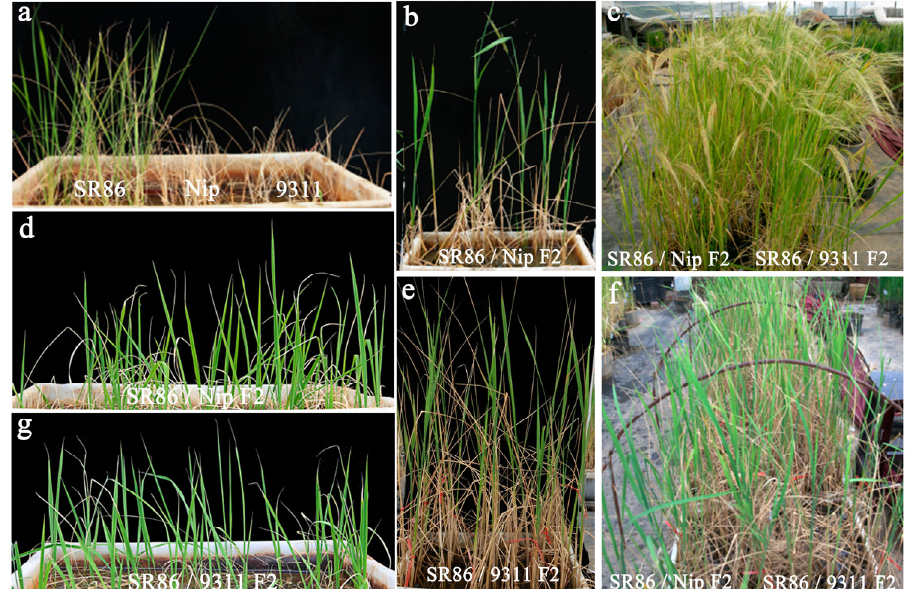
Figure 3. The phenotypic and genetic analyses of SR86 under salt stress. ( a ) Phenotype of SR86, Nip, and 9311 plants exposed to 150 mM NaCl. ( b ) Phenotype of SR86 × Nip F 2 plants grown in the presence of 150 mM NaCl during the reproductive growth period. ( c ) Phenotype of SR86 × Nip F 2 plants and SR86 × 9311 F 2 plants under normal conditions. ( d ) Phenotype of SR86 × Nip F 2 plants at seedling stage in the presence of 150 mM NaCl. ( e ) Phenotype of SR86 × 9311 F 2 plants grown in the presence of 150 mM NaCl during the reproductive growth period. ( f ) Phenotype of SR86 × Nip F 2 plants and SR86 × 9311 F 2 plants under 150 mM NaCl conditions. ( g ) Phenotype of SR86 × 9311 F 2 plants at seedling stage in the presence of 150 mM Table 1. The mapping and screening of salt tolerance candidate genes.